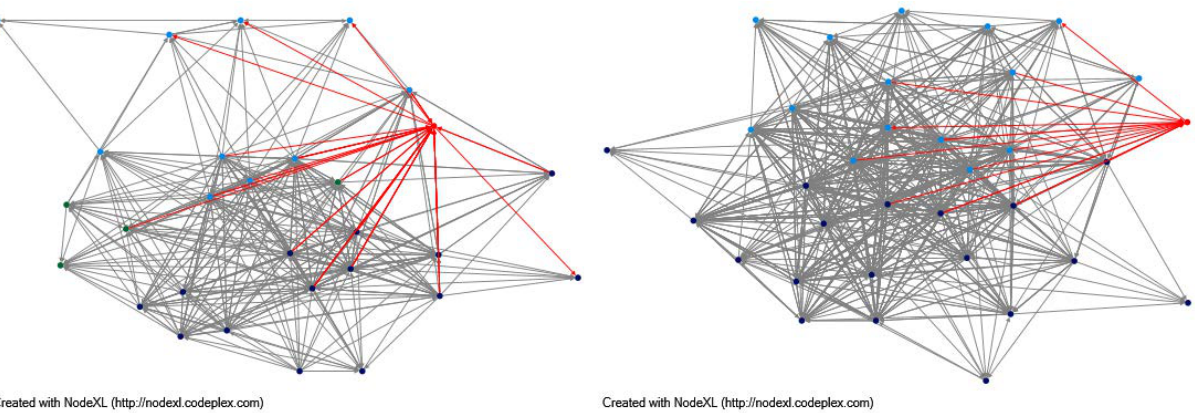
Figure 4a. A egocentric network graph of a “recognized member” (initial four weeks)